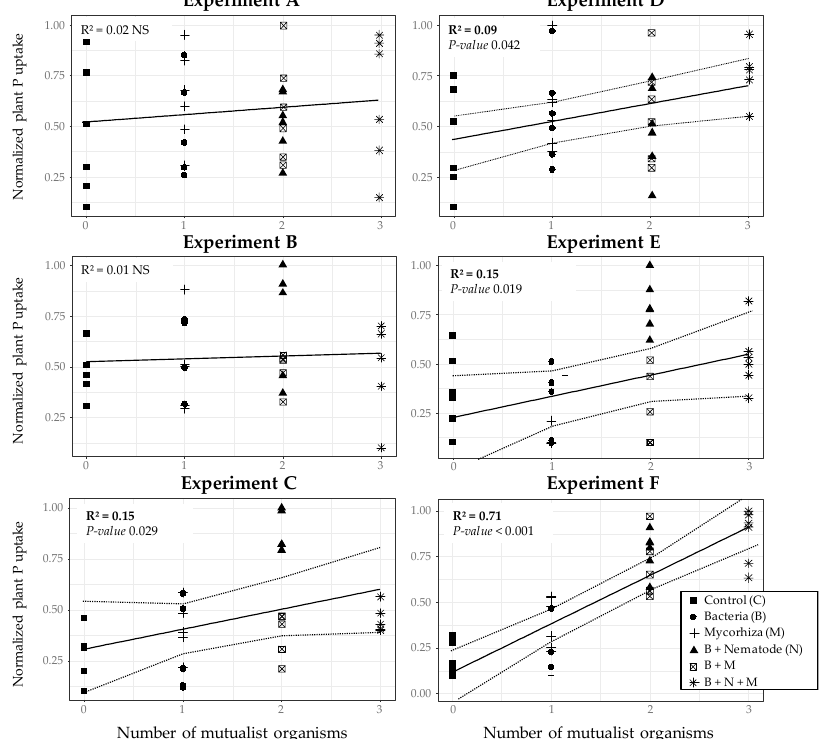
Figure 1. Linear relationships (full line) and 95% interval confidence (dotted lines) between the number of plant mutualists inoculated in the rhizosphere of Pinus pinaster and plant P acquisition (normalized between 0.1 and 1) according to the experiments. The medium was agarose without P addition in experiment A, supplemented with mineral P (Pi) in experiment B or amended with phytate in experiment C. We used a soil-bead mixture (soil) without P addition in experiment D, fertilized by Pi in experiment E or amended with phytate in experiment F. The letters “C”, “B”, “M”, and “N” refer to control (plant alone), bacteria ( Bacillus subtilis ), mycorrhiza ( Hebeloma cylindrosporum ), and nematode ( Rhabditis sp .), respectively. NS indicates non-significant regression. Table 2. Coefficients of the fitting generalized linear model (glm; AIC -61.653). Significant terms (< 237 0.05 threshold) are in bold.